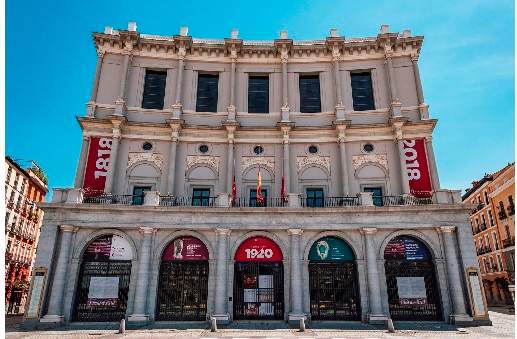
Figure 1. Main façade of the Opera House of Madrid. Courtesy of Fundacion del Teatro Real. The Opera House is open from September to July and closed in August every year. Madrid climate changes abruptly with cold winters, with an average of 0 ◦ C (32 ◦ F), and hot summers, with an average of 35 ◦ C (95 ◦ F), requiring heating and cooling. Teatro Real is also used out of the shows for rehearsals, celebrations, and product launches, making the HVAC operation a complex